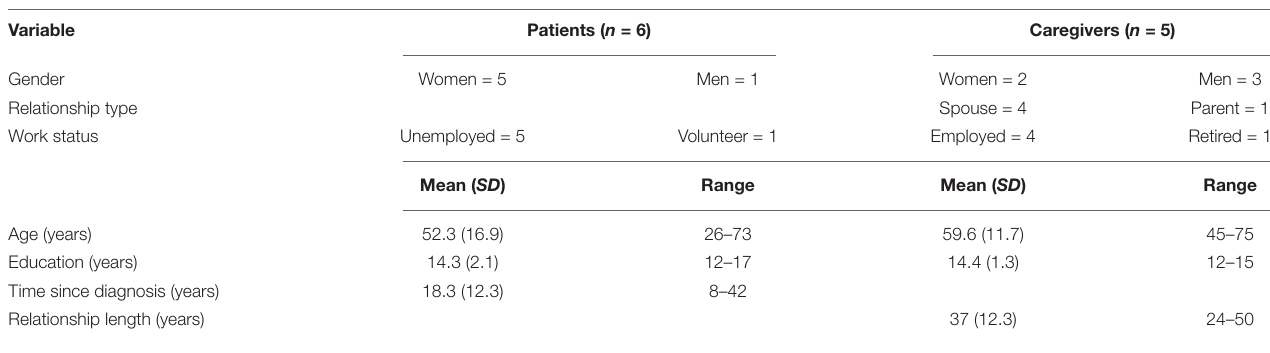
TABLE 1 | Participant demographic